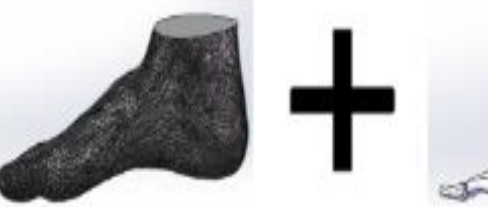
Figure 1. Whole foot model geometry.